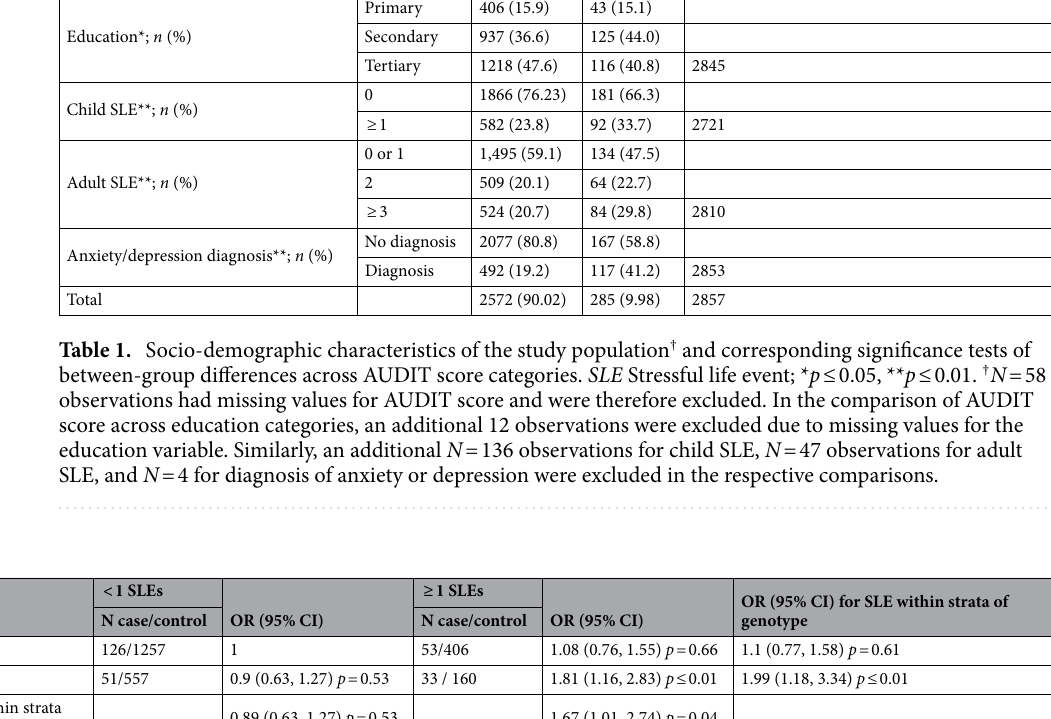
Table 2. Additive interaction between CNR1’s rs2023239 genotype and child SLEs on the odds of problematic alcohol use (i.e., AUDIT score ≥ 8). Case/control refers to problematic alcohol use (yes/no). OR Odds Ratios, CI Confidence Interval, SLE Stressful life event. Estimates adjusted for age, sex, and diagnosis of anxiety or depression. Crude RERI estimate 0.84 (95% CI: − 0.05–1.74; p = 0.07). Adjusted RERI estimate 0.83 (95% CI: 0.0–1.67; p = 0.05), calculated with values from table above: 1.81 − 0.9 − 1.08 + 1 = 0.83.